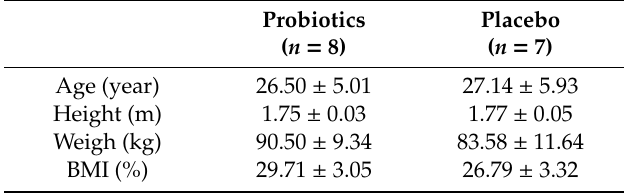
Table 1. Characteristics of the study subjects (intervention ver., Part